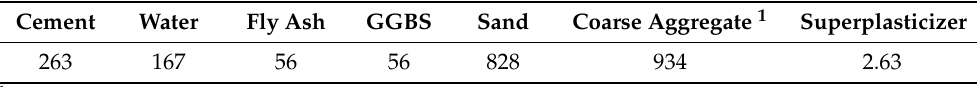
Table 1. Mix composition of ready-mixed concrete (unit: kg/m 3 ).